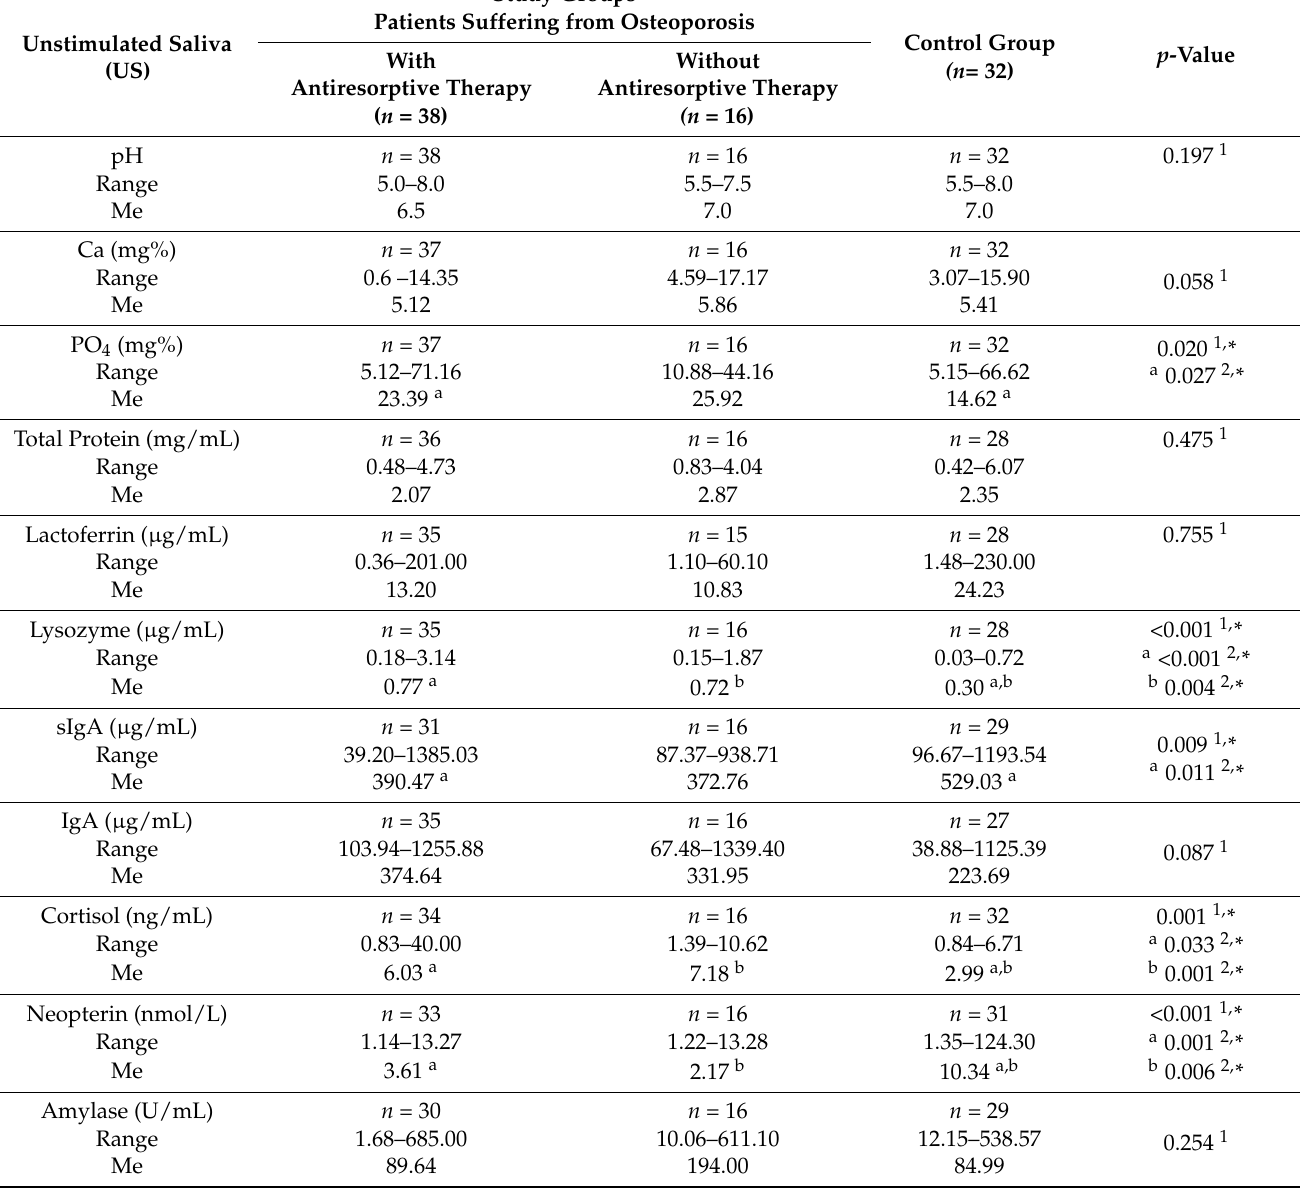
Table 1. Comparison of biochemical parameters in unstimulated saliva from the study groups and the control